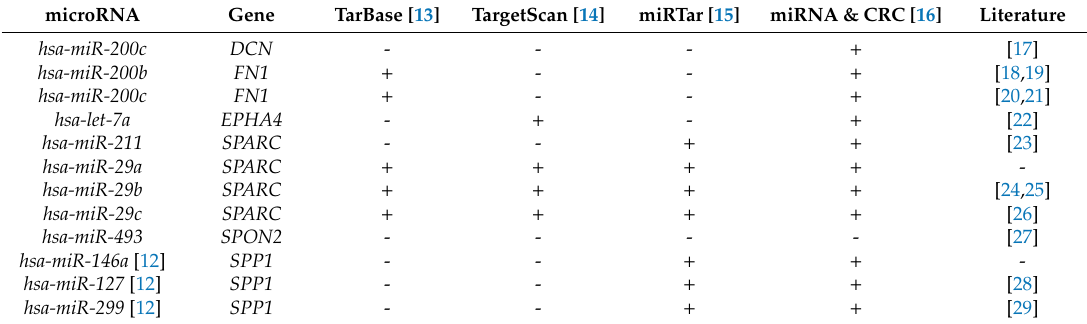
Table 2. Results of database search for regulatory microRNAs of ECM-related genes.